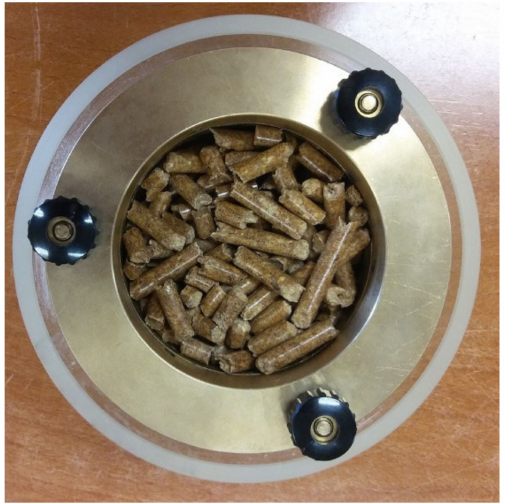
Figure 5. A sample of wood pellets inside one of the oedometric cells.